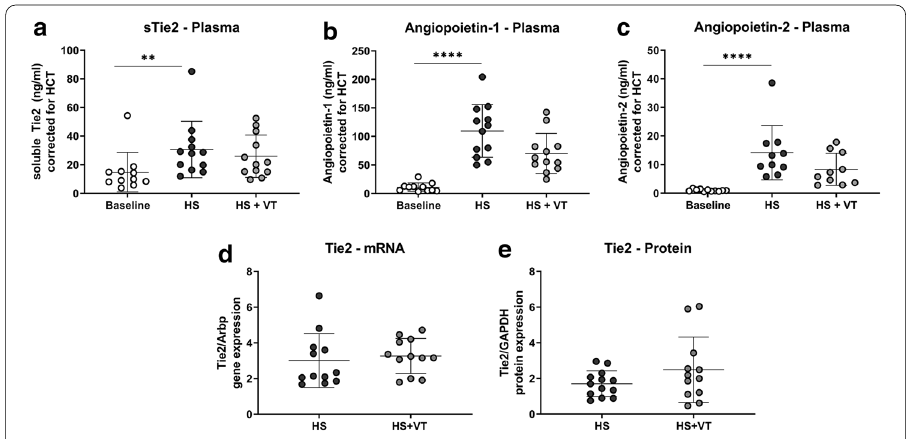
Fig. 3 Expression levels of the angiopoietin/Tie2 system. Plasma levels of soluble Tie2 ( a ), angiopoietin-1 ( b ) and angiopoietin-2 ( c ), measured at baseline (white circles) and following hemorrhagic shock and fluid resuscitation (HS; black circles, HS VT; grey circles). Renal gene expression of Tie2 ( d ) and renal protein + expression of total Tie2 ( e ) measured at 4 h after fluid resuscitation (HS; black circles, HS VT; grey circles). + Data represent mean SD. Plasma: Kruskal–Wallis with Dunn’s analyses. Gene and protein expression: ± VT vs. HS group. VT; Student’s T-test. *P < 0.05 HS group compared to baseline; # P < 0.05 HS + Renal perfusion assessed with contrast echography Renal microvascular blood volume ( A ) was not affected by hemorrhagic shock nor fluid resuscitation (Fig. 2d; 246 149 vs 206 149 a.u. p > 0.99, R 4 h vs baseline). Induc- ± ± + tion of hemorrhagic shock decreased microvascular filling velocity ( β ; Fig. 2e; from baseline: 1.3 0.7 to 1 h HS: 0.4 0.2 s − 1 , p < 0.0001), which partly restored by fluid ± ±